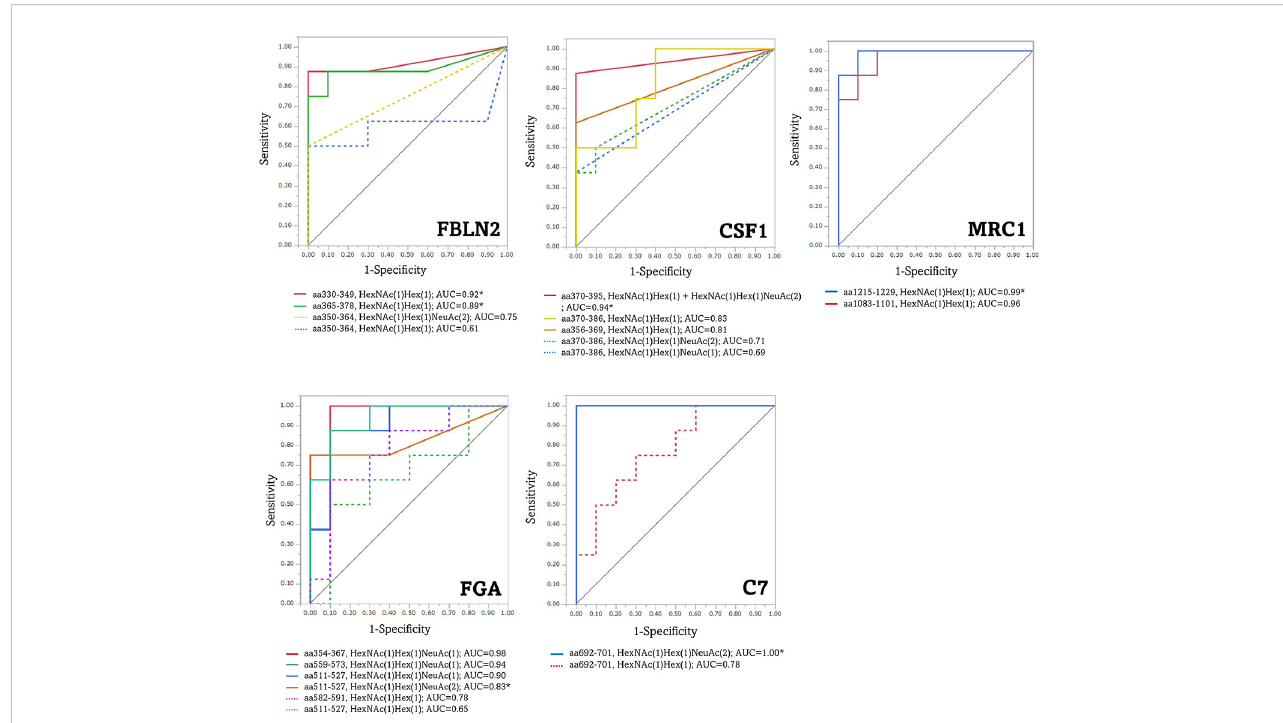
FIGURE 7 Receiver operating characteristic (ROC) curves for the diagnosis of advanced CRC by aberrant O-glycoforms. *, signi fi cant O-glycoforms. FBLN2, fi bulin- 2; CSF1, colony-stimulating factor 1; MRC1, macrophage mannose receptor 1; FGA, fi brinogen alpha chain; C7, complement component